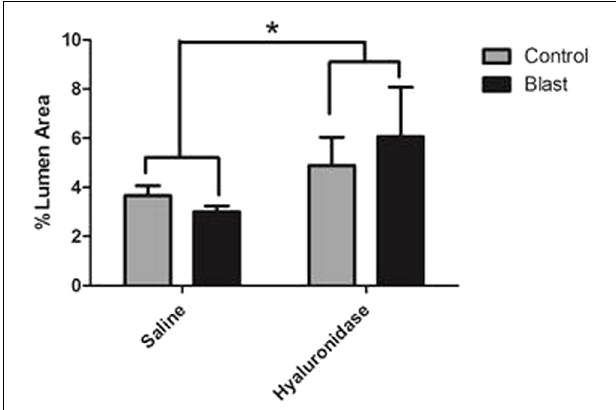
FIGURE 5 | Hyaluronidase infusion significantly increased glycocalyx thickness in sham and blasted rats. Mean area of the glycocalyx quantified from the cerebral cortex of rats from each treatment group and expressed as a percentage of the total capillary lumen area (B). Capillaries from hyaluronidase infused rats showed a significant increase in percent lumen area of the glycocalyx in both sham exposed (HC, 4.886%) and blast exposed (HB, 6.067%) groups when compared to saline infused sham exposed (SC, 3.262%) and blast exposed (SB, 3.517%) groups. Asterisk denotes global significance between saline and hyaluronidase treatment groups (3.389% vs. 5.47%, Two-way ANOVA p =